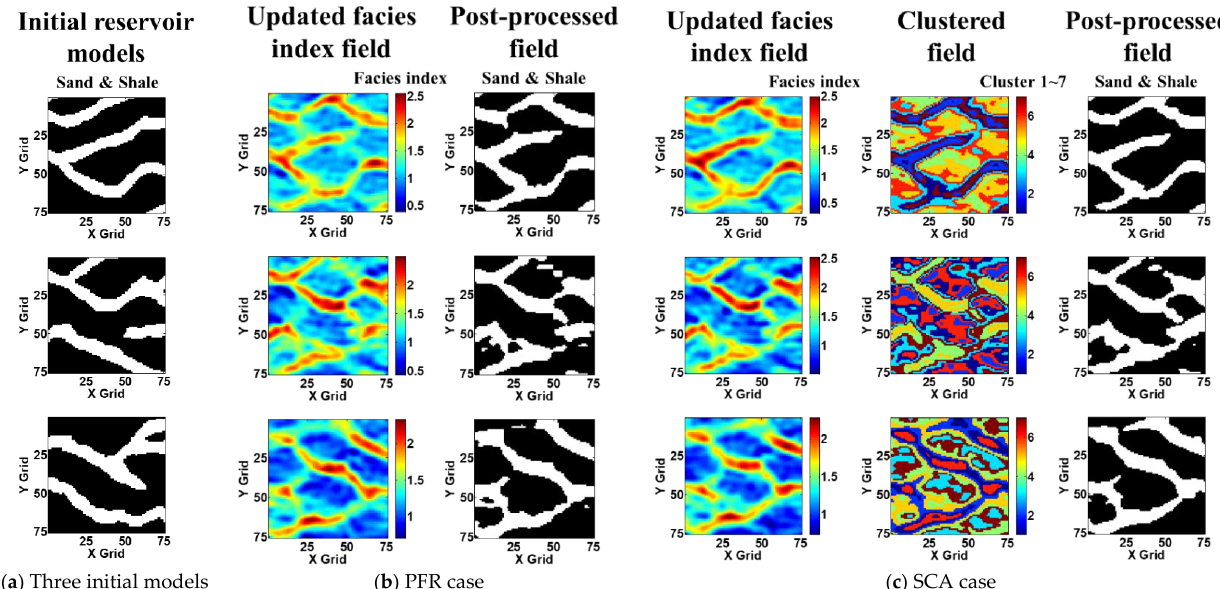
Figure 9. PFR and SCA applications on three reservoir models.